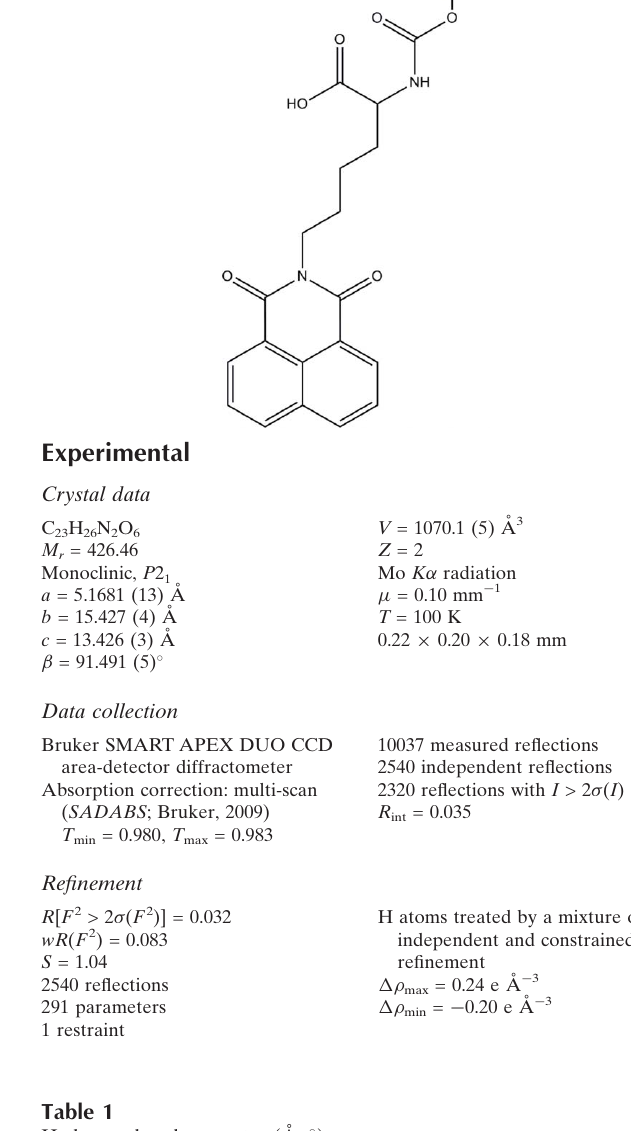
Hydrogen-bond geometry (A˚ , (cid:2)